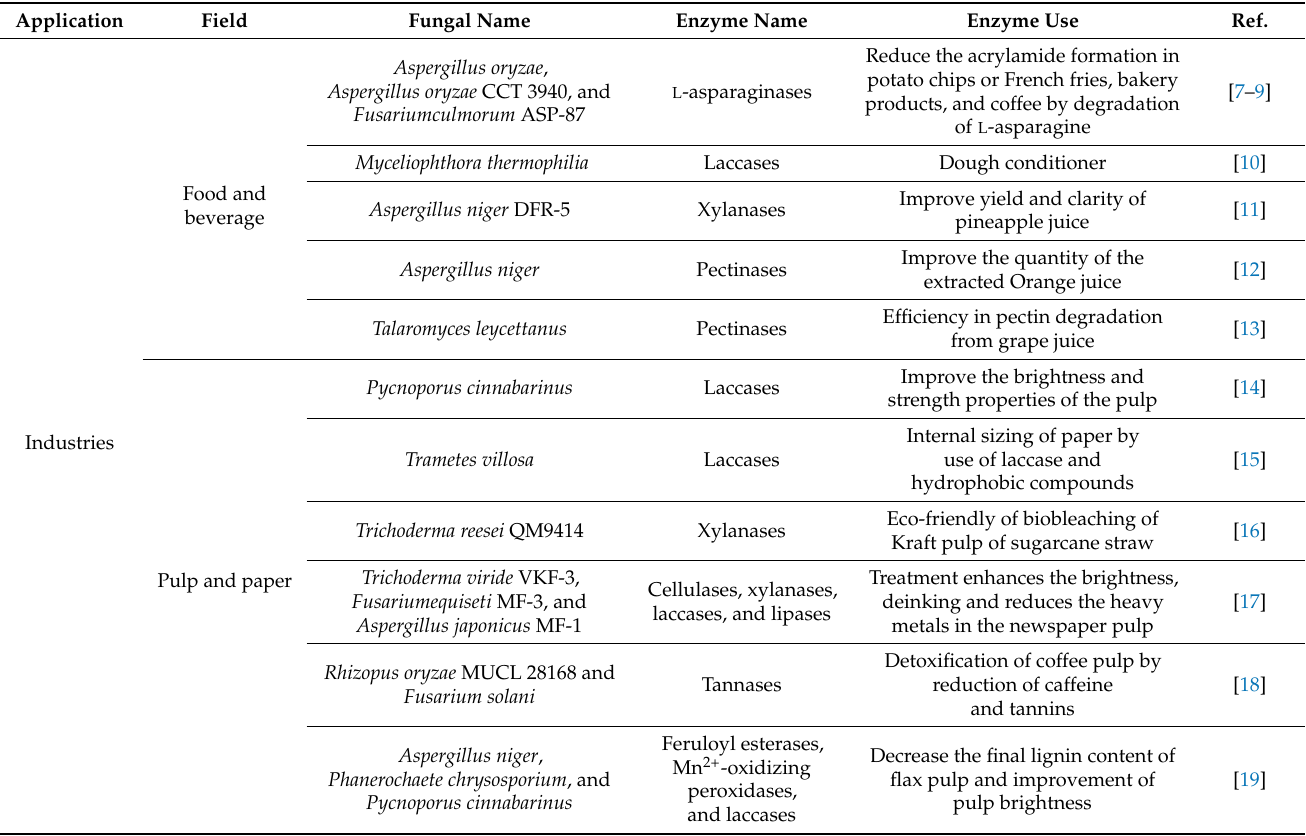
Table 1. General application of fungal enzymes in different